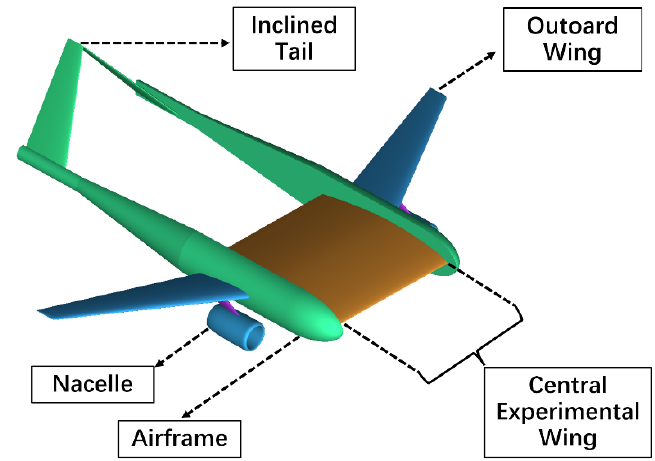
Figure 1. Aircraft model with a central experimental wing.